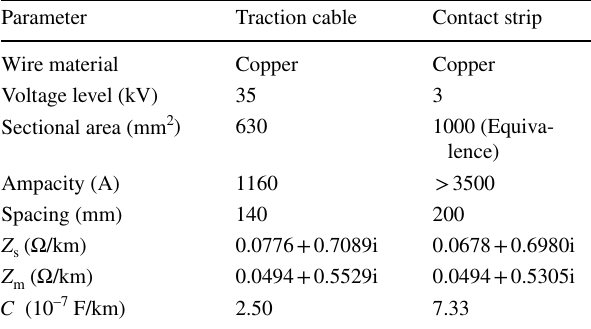
Table 1 Main parameters of two-stage power supply network Parameter Traction